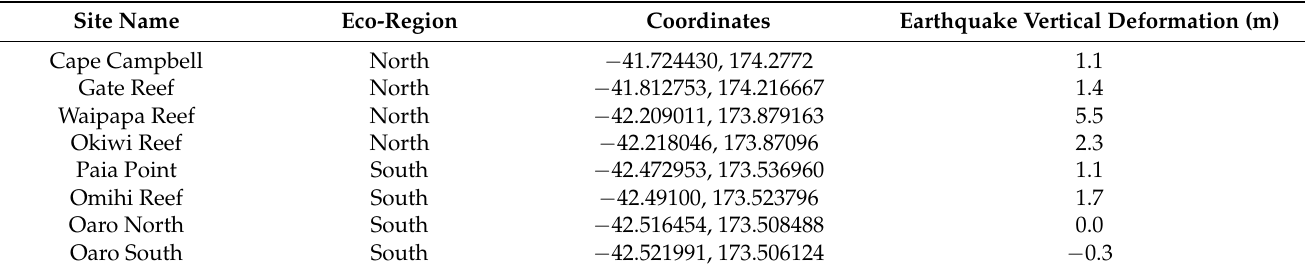
Table 1. Details of sites for which aerial imagery was captured along the Kaik¯oura coast affected by the November 2016 7.8 Mw earthquake, including the Latitude and Longitude, and vertical deformation (m)